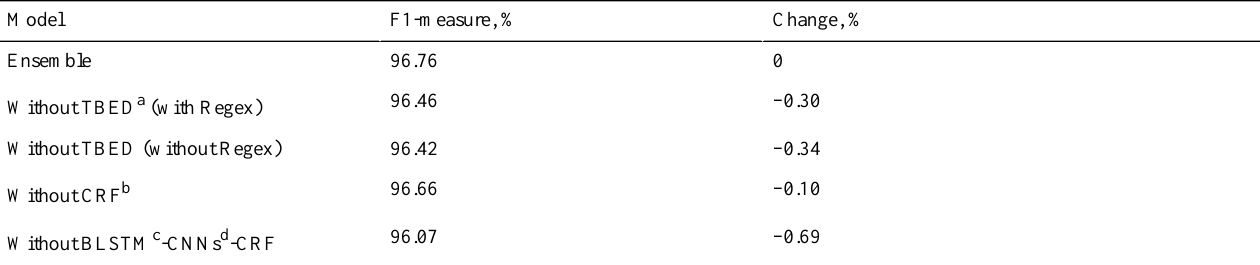
Table 6. Results of the hybrid system without submodels (i2b2 categories, strict entity matching).